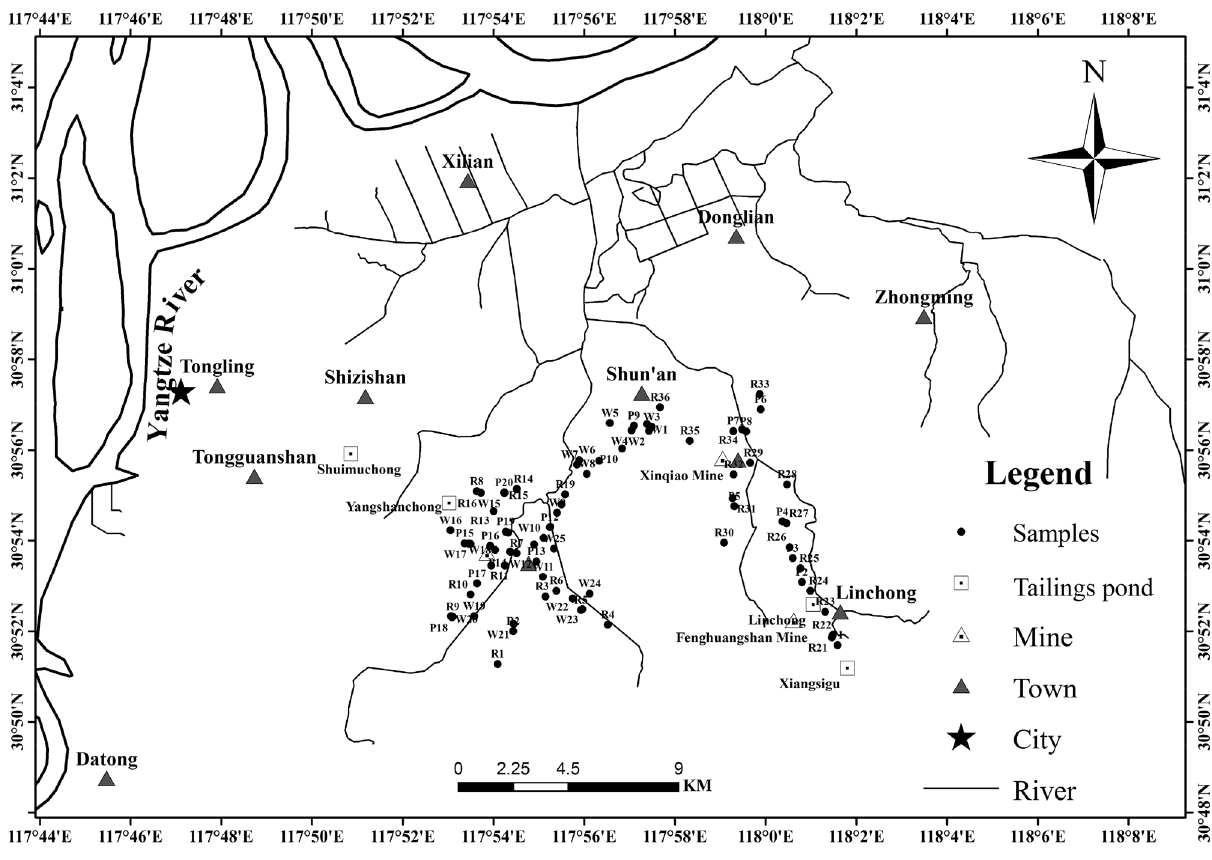
Figure 1. Location map of the study area and topsoil